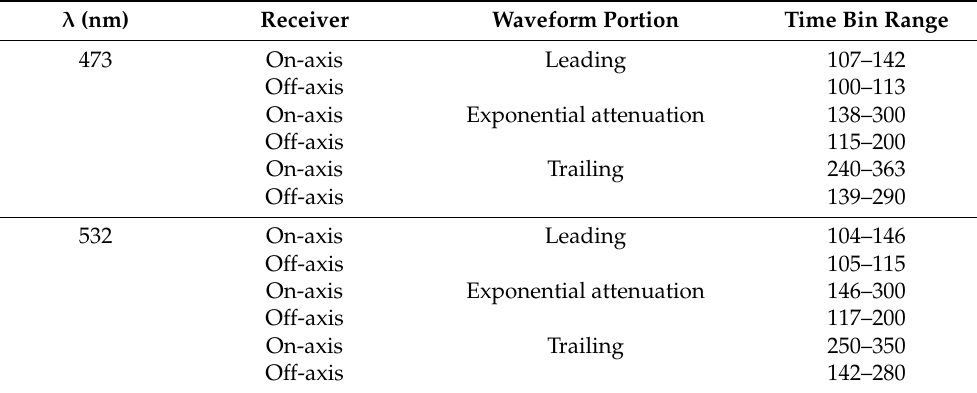
Table 2. Segmentation of LiDAR measurements based on time-resolved power